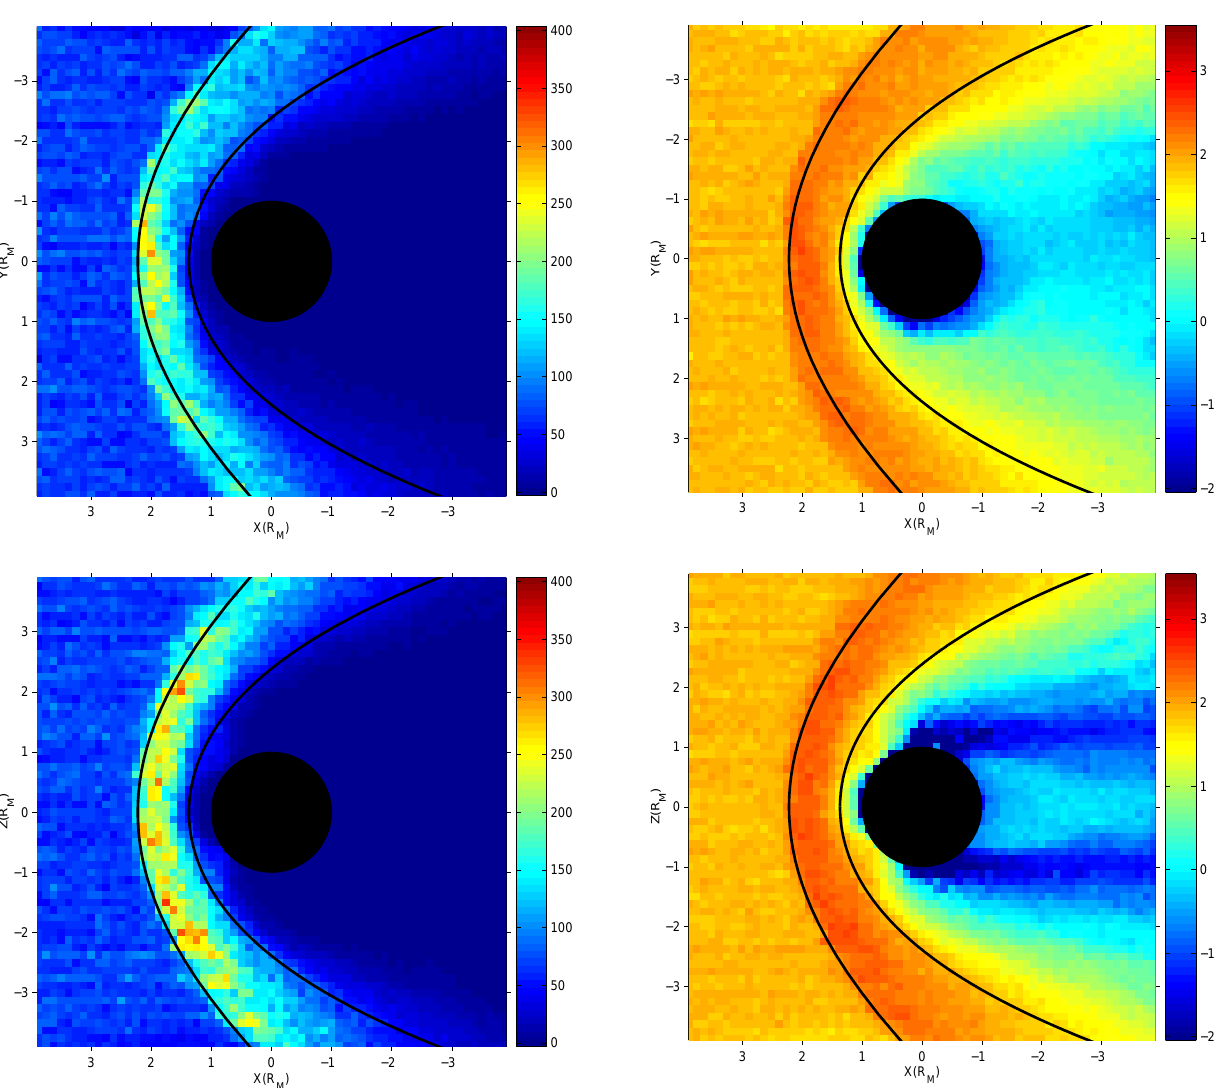
Fig. 4. The density of the solar wind protons, n (H + ), in a closed magnetosphere case on (top) the XY plane and on (bottom) the XZ - plane in cm − 3 in a logarithmic